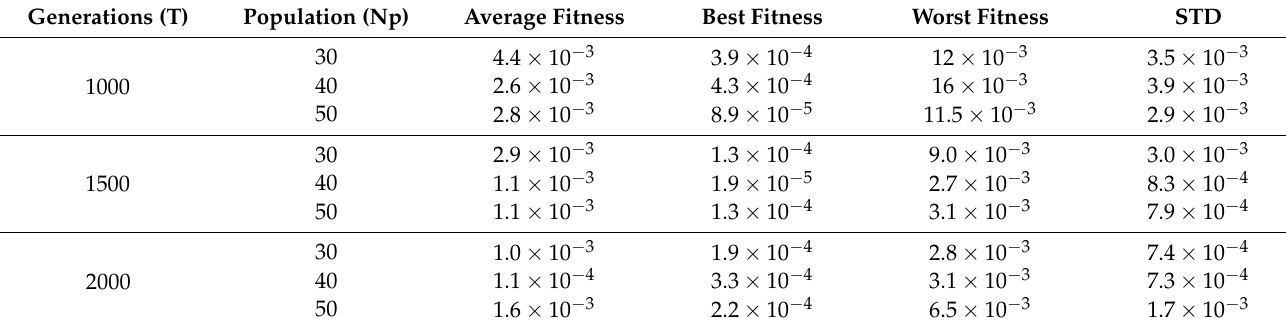
Table 5. AO parameter analysis for case